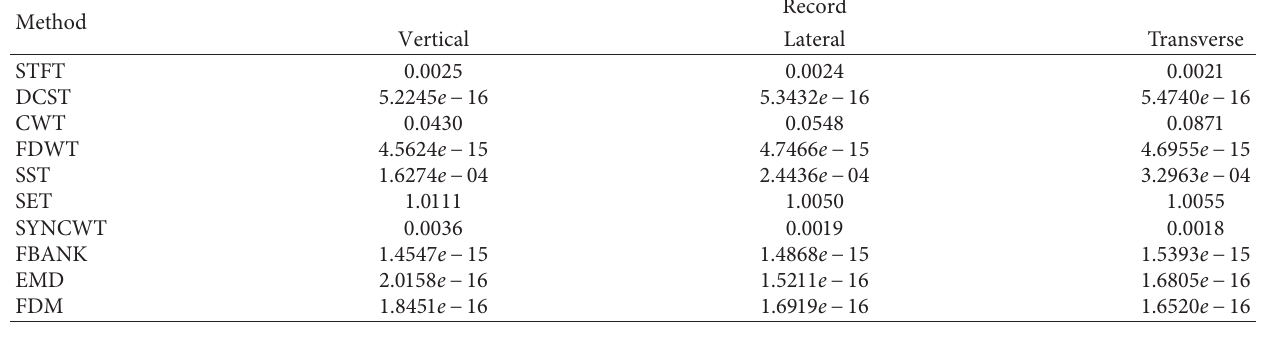
Table 2: Relative errors of Mosha3 station accelerogram components.